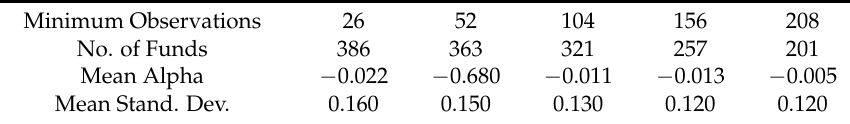
Table 2. Breakdown of Funds by Length of Fund